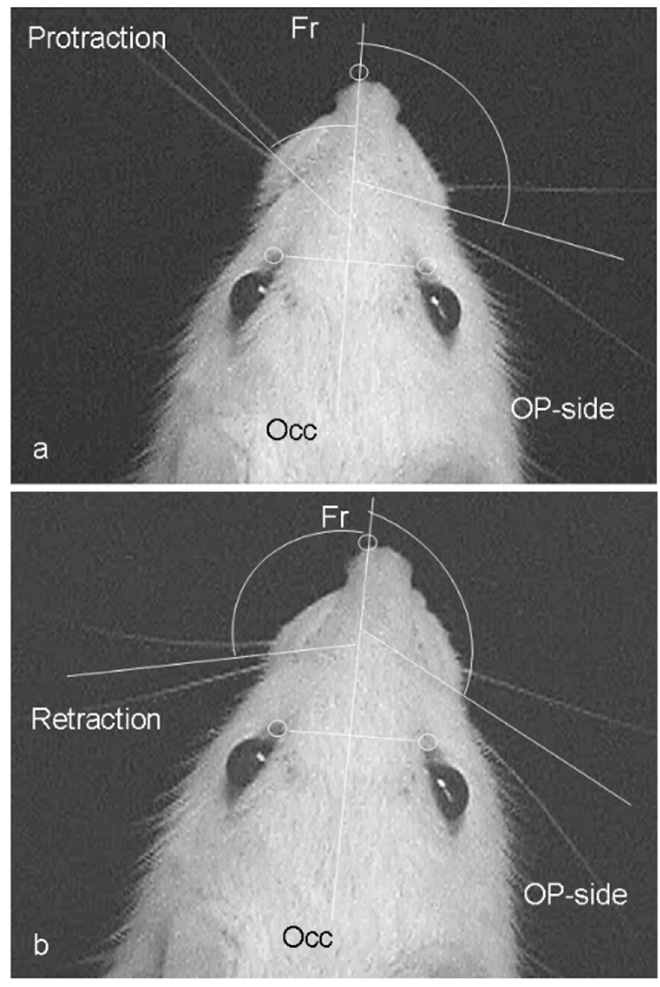
Figure 1. Video-based motion analysis of vibrissae motor performance on the left unoperated and right operated sides (OP-side) of the rat. Angles, angular velocity, and angular acceleration were measured during vibrissal protraction ( a ) and retraction ( b ). Note the significant change in angle from a sagittal line [Fr-Occ, which connects the frontally located tip of the nose (Fr) with the occipital bone (Occ)] during protraction and retraction on the intact side. The vibrissae on the operated side remain spastic (From Guntinas-Lichius et al., 2002) [59].